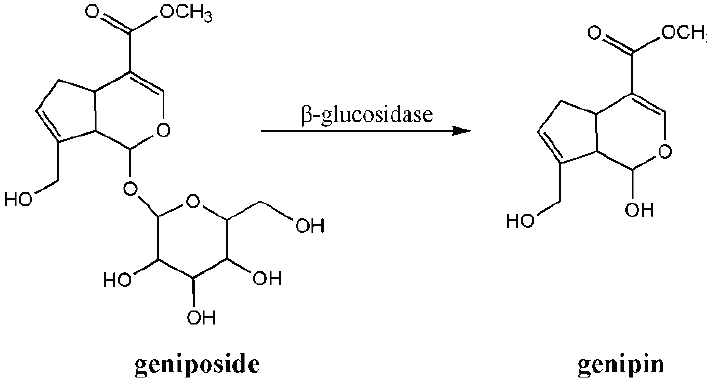
Figure 5. Chemical formulas for geniposide and genipin.